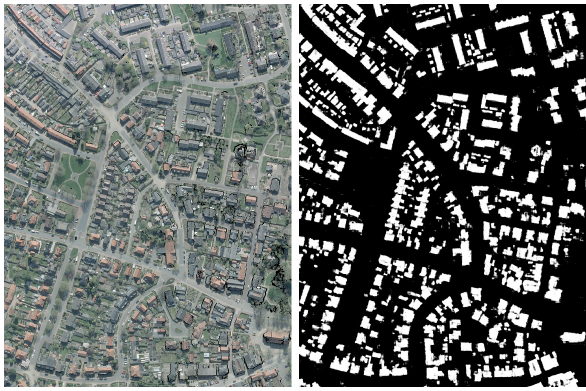
Figure 1. An aerial image (area of 370 × 495 meters) and its respective output produced by our